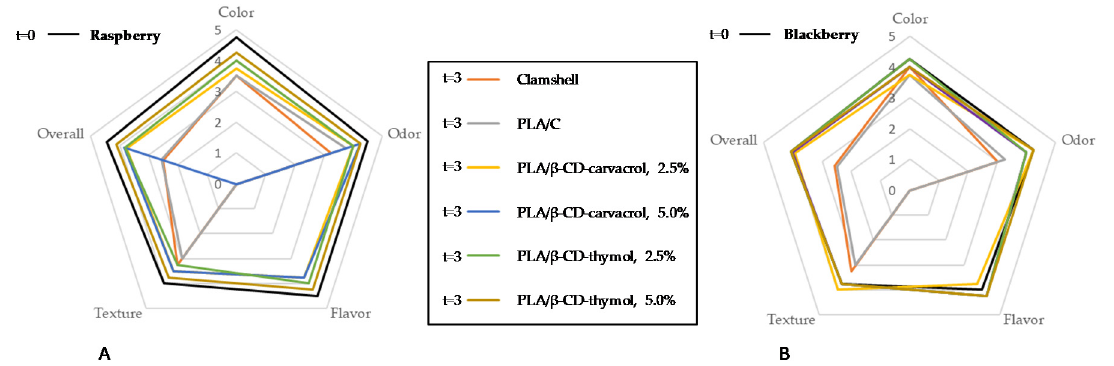
Figure 6. Effect of the type of packaging and storage time (0, 7, 14, 21 days) at 4 °C on sensory attributes of raspberries ( A ) and blackberries ( B ).